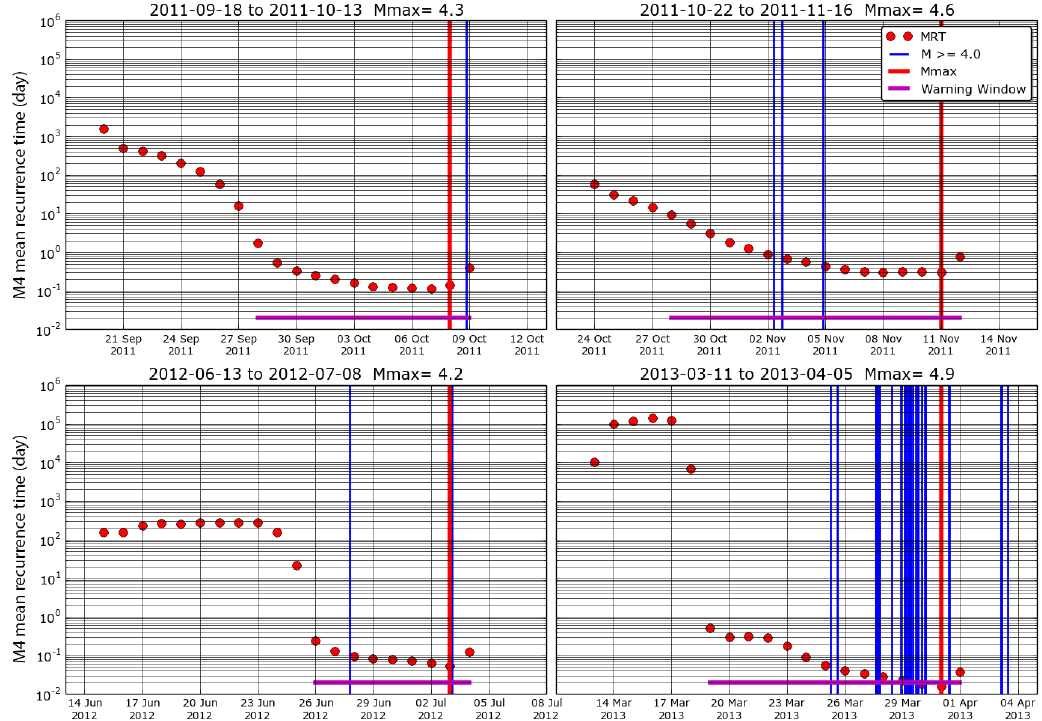
Figure 6. MRT evolution (computed using MLE) for four periods: 18 August 2011 to 10 October 2011; 22 October 2011 to 13 Novem- ber 2011; 13 June 2012 to 5 July 2012; and 11 March 2013 to 2 April 2013. The warning windows were triggered when MRT dropped below 10 days.